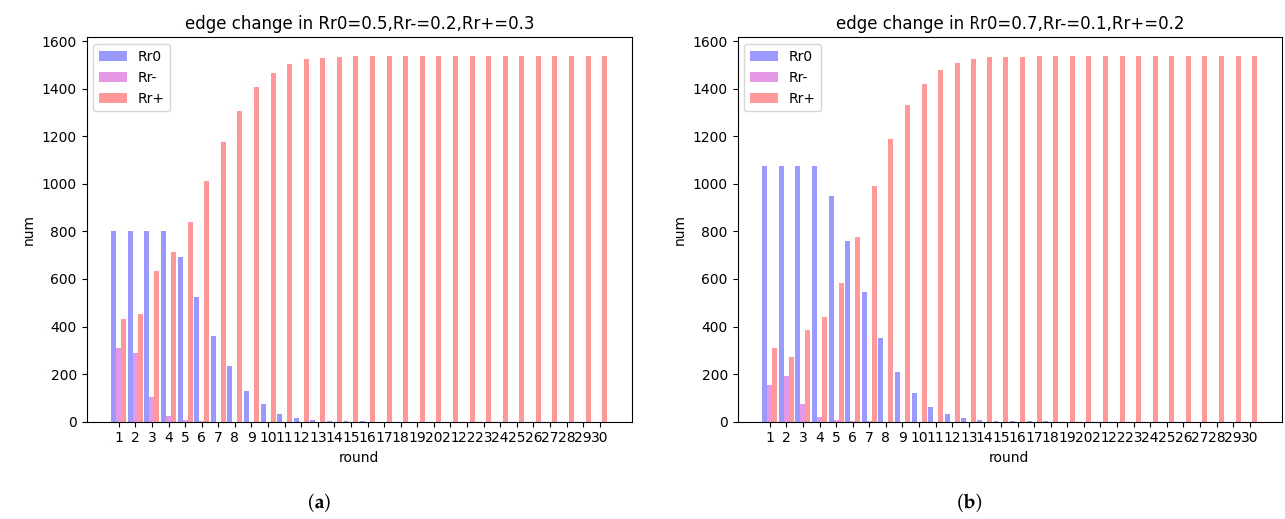
Figure 20. Changes in the number of various edges: ( a ) edges change in R r 0 = 0.5, R r − = 0.2, R r + = 0.3; ( b ) edges change in R r 0 = 0.7, R r − = 0.1, R r + =